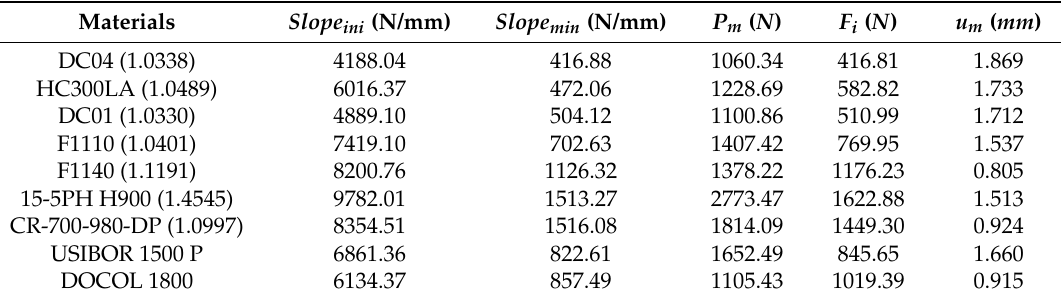
Table 6. Experimental SPT parameters.